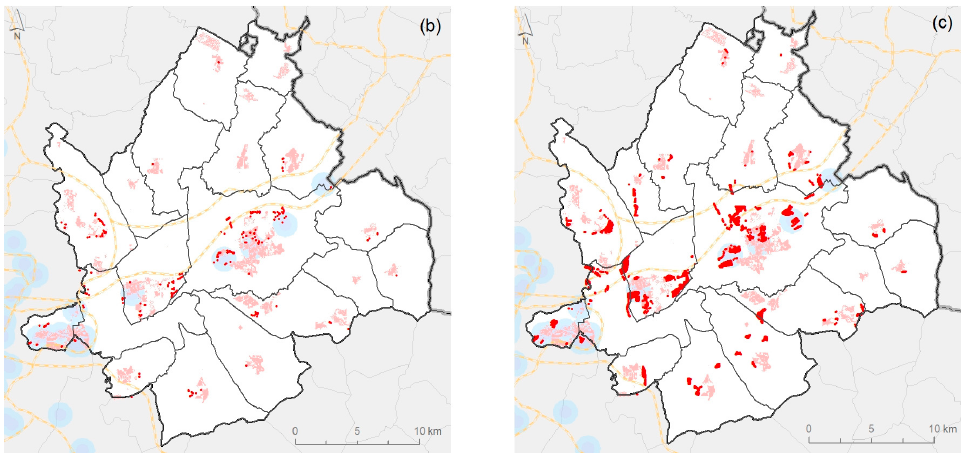
Figure 9. Spatial results for the three simulation scenarios: ( a ) sustainable, ( b ) crisis, and ( c ) speculative.